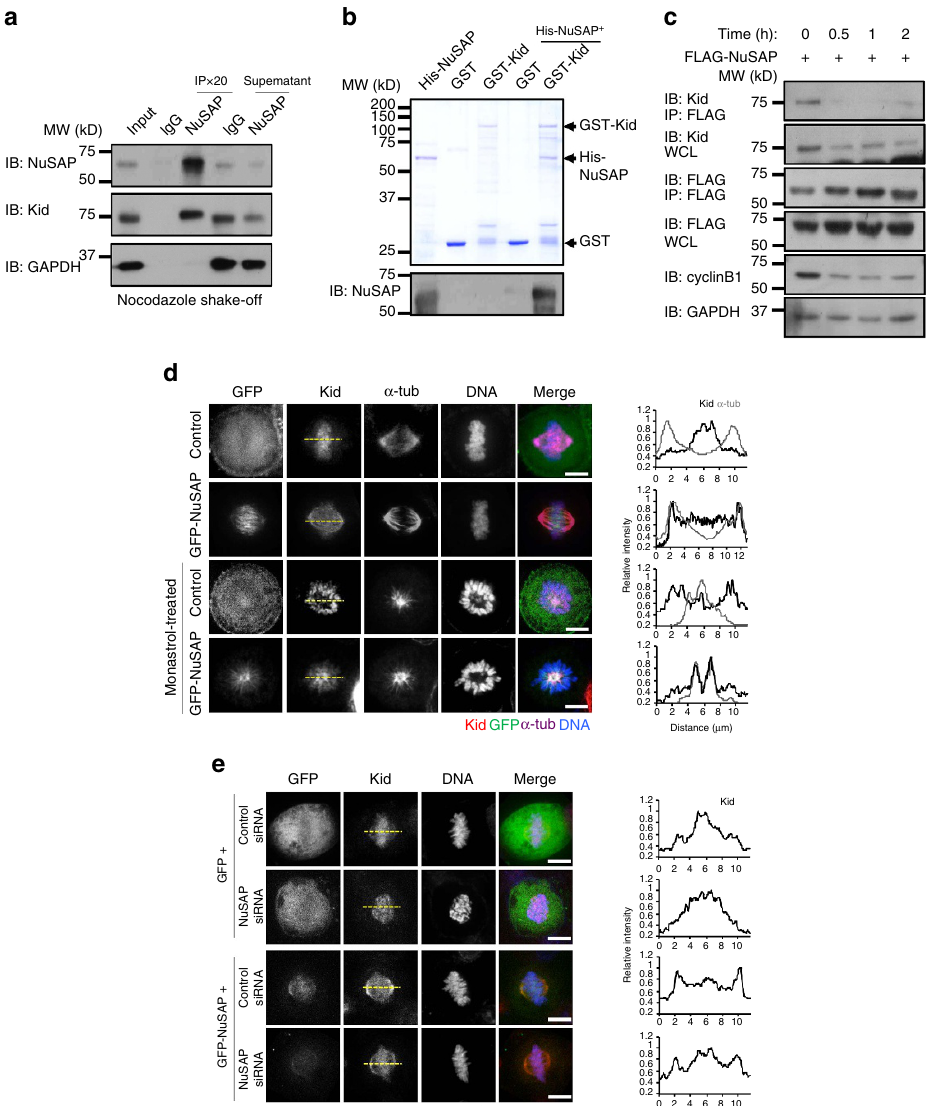
Figure 2 | NuSAP binds Kid and regulates its localization at microtubules. ( a ) NuSAP binds Kid endogenously. Synchronized HeLa cell lysates were incubated with 2 m g rabbit IgG or NuSAP antibody bound to protein A-Sepharose beads. The immunoprecipitated proteins and supernatants were blotted with anti-Kid, anti-NuSAP and anti-GAPDH antibodies. ( b ) NuSAP binds Kid in vitro . Purified His-NuSAP recombinant protein was incubated with either GSTor GST-Kid recombinant protein. GSTwas pulled down and NuSAP was blotted with an anti-NuSAP antibody. ( c ) Immunoprecipitation of NuSAP with Kid was conducted with whole-cell lysates of HeLa cells transfected with FLAG-NuSAP after release from thymidine/nocodazole arrest into fresh medium at the indicated time points. The immunoprecipitated protein and the whole-cell lysates were blotted with anti-Kid, anti-FLAG, anti-cyclin B1 and anti-GAPDH antibodies. ( d ) Kid localization at the kinetochore region in bipolar metaphase HeLa cells and monastrol-treated monopolar cells expressing GFP-NuSAP and the GFP-vector (control). Cells were stained with anti- a -tubulin and Hoechst 33342. The line profile of Kid localization (black) according to a -tubulin (grey) is represented in the right-hand graph. Scale bar, 5 m m. ( e ) Kid localization in bipolar metaphase HeLa cells transfected with control siRNA or NuSAP siRNA together with GFP-vector or GFP-NuSAP. The line profile of Kid localization (black) is represented in the right-hand graph. Scale bar, 5 m m. NuSAP (1.39 ± 0.03 m m min (cid:2) 1 ) or Kid (1.54 ± 0.06 m m min (cid:2) 1 ) significantly reduced the centre oscillation velocity compared with the control-depleted cells (1.68 ± 0.06 m m min (cid:2) 1 ). The centromeres in the NuSAP- or Kid-depleted cells had a lower proportion in the large velocity range (2-4 m m min (cid:2) 1 ) than that in the control cells (Fig. 3f), indicating that the depletion of NuSAP or Kid markedly reduced the high velocity of oscillation. As the velocity varies with the position of the centromere during oscillation and the maximum velocity is reached near the equator was also calculated. As shown in Fig. 3e, the depletion of either with the minimum ICD 7,38 , we further investigated whether NATURE COMMUNICATIONS|7:10597|DOI: